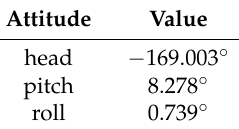
Table 2. Initial